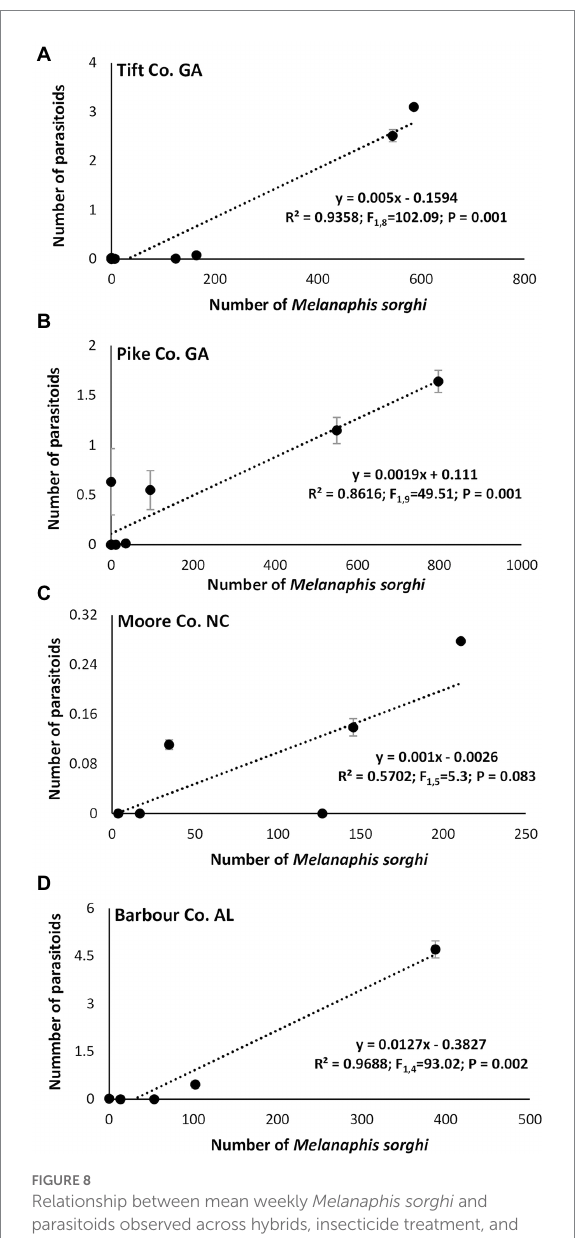
FIGURE 8 Relationship between mean weekly Melanaphis sorghi and parasitoids observed across hybrids, insecticide treatment, and